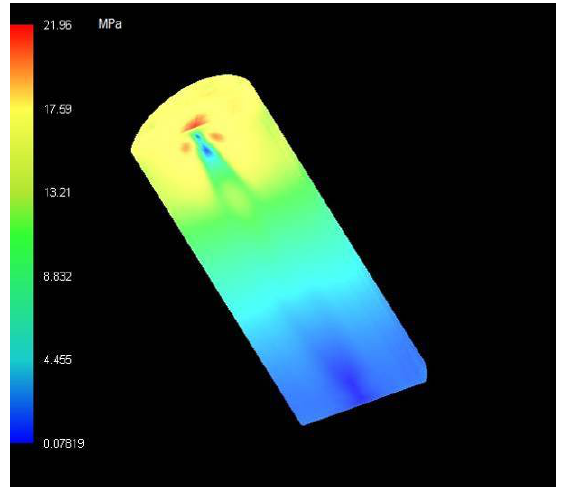
Fig. 2 Simulated stress intensity (MPa) in end pumped Nd: YLF rod of 4 mm diameter and 10 mm in length, pumped at 30 W.